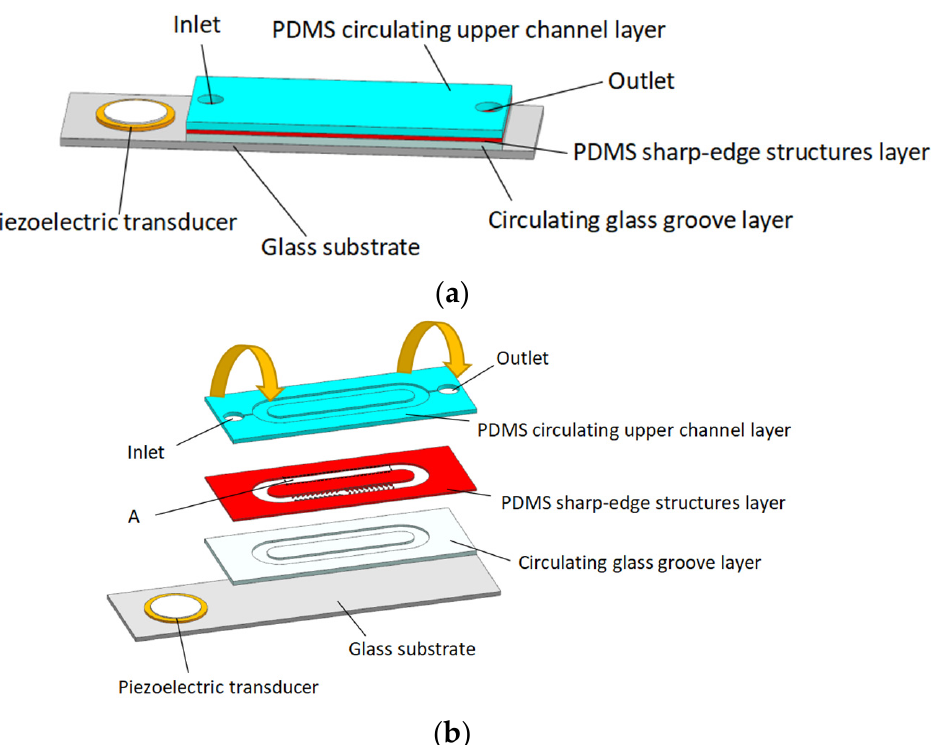
Figure 1. Structure diagram of acoustic micropump: ( a ) Overview of acoustic micropump; ( b ) Ex- ploded view of acoustic micropump.